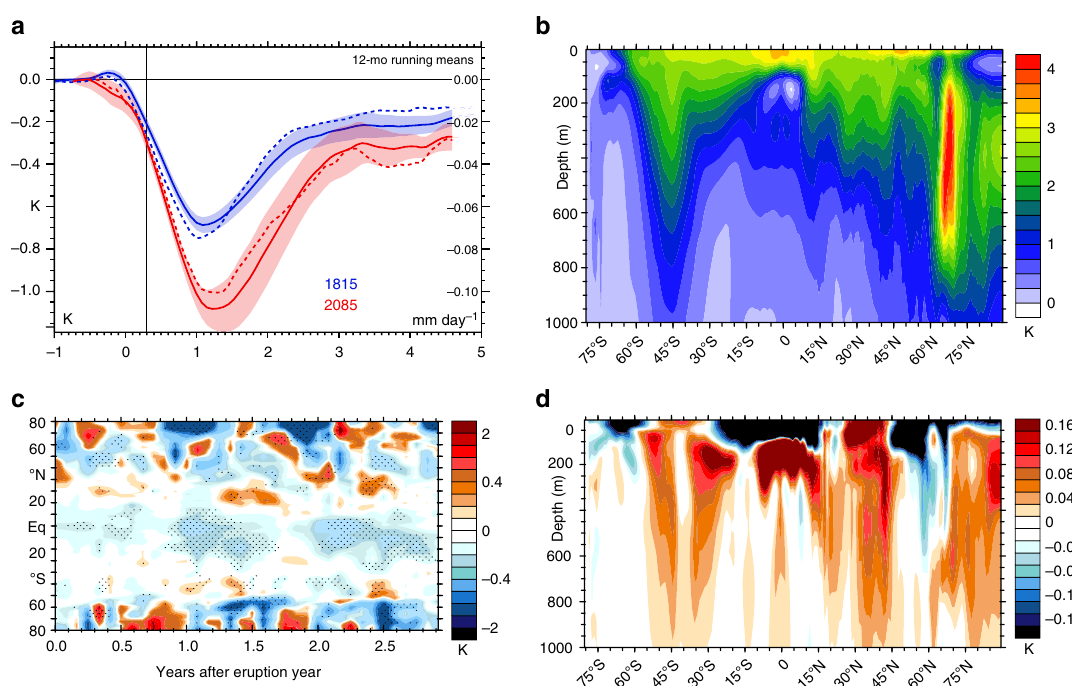
Fig. 7 Changes in eruption responses in surface and ocean temperatures between 1815 and 2085. Ensemble mean-simulated a anomalies in global mean surface temperature (K) and rainfall (mm day − 1 , dashed, right axis) for 1815 (blue) and 2085 (red) eruptions, smoothed with a 12-mo running mean and shown with a 2 standard error range for temperature (shading), b annual mean net ocean warming by latitude and depth estimated from the 2085 – 2094 change from 19th century ensemble zonal mean, c differences in ensemble zonal mean 2-m air temperature anomalies between the 2085 and 1815 eruptions (stippled where anomalies exceed twice the standard error), and d the 2086 – 1816 difference in ensemble zonal mean ocean temperature anomalies by latitude and depth. Years indicated on the abscissas begin at the corresponding tick marks